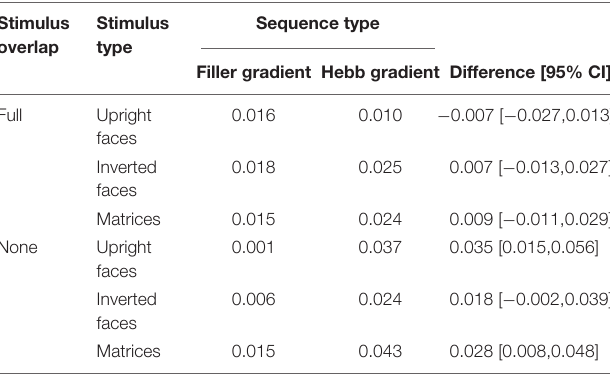
TABLE 1 | Mean improvement gradients for the filler and Hebb sequences across the six experimental